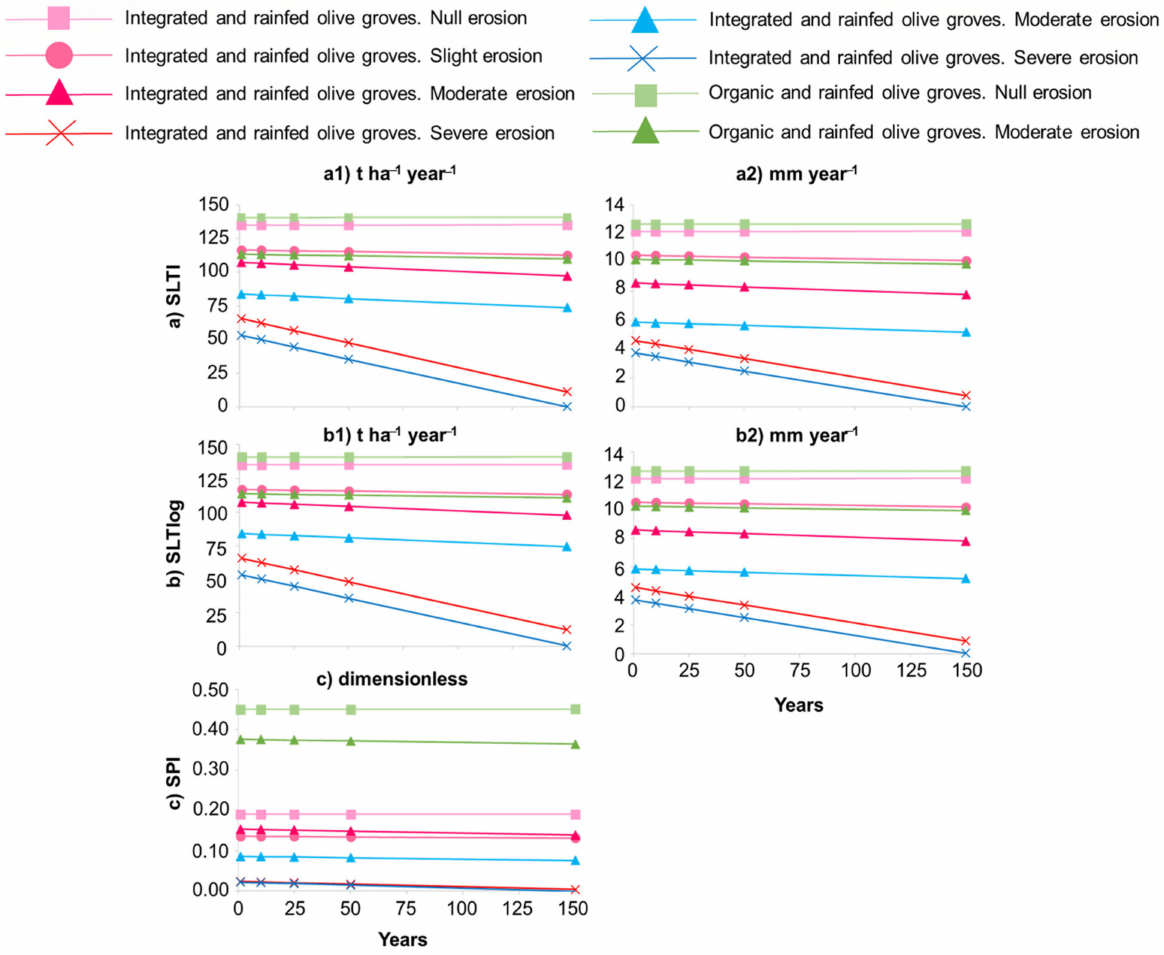
Figure 4. SLTI (t ha − 1 year − 1 ( a1 ) and mm year − 1 ( a2 )), SLTIog (t ha − 1 year − 1 ( b1 ) and mm year − 1 ( b2 )), and SPI ( c , dimensionless) indices for the olive grove types and related soil erosion levels calculated in the PDO Estepa. Each mark on the trendlines represents the timescale projections considered, respectively, corresponding to 1, 10, 25, 50, and 150